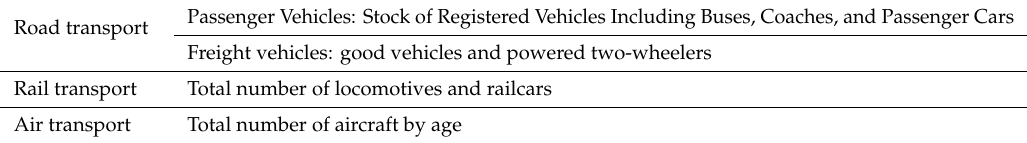
Table 4. Number of assets for road, rail and air